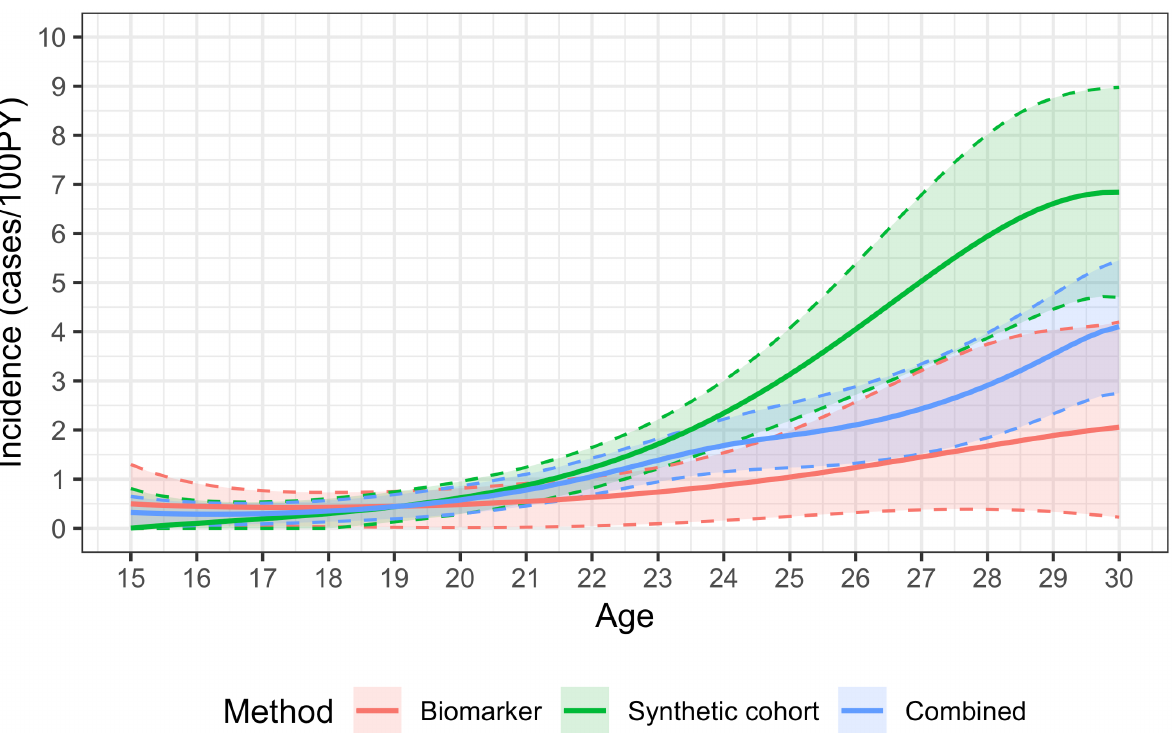
Fig 2. HIV incidence by age in males aged 15-30, using the synthetic cohort, recency biomarker and combined methods.